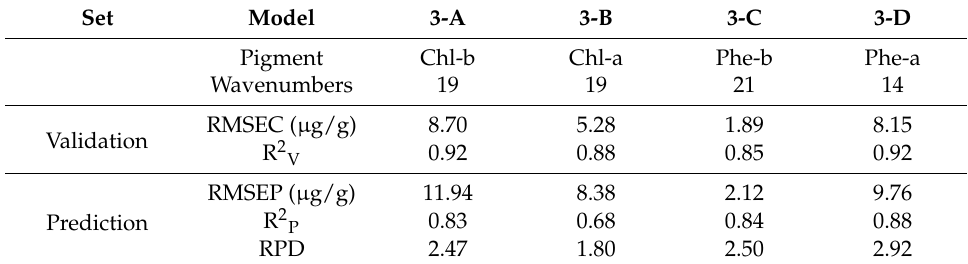
Table 4. The model results based on wavenumbers selected by the combination of biPLS and SPA.